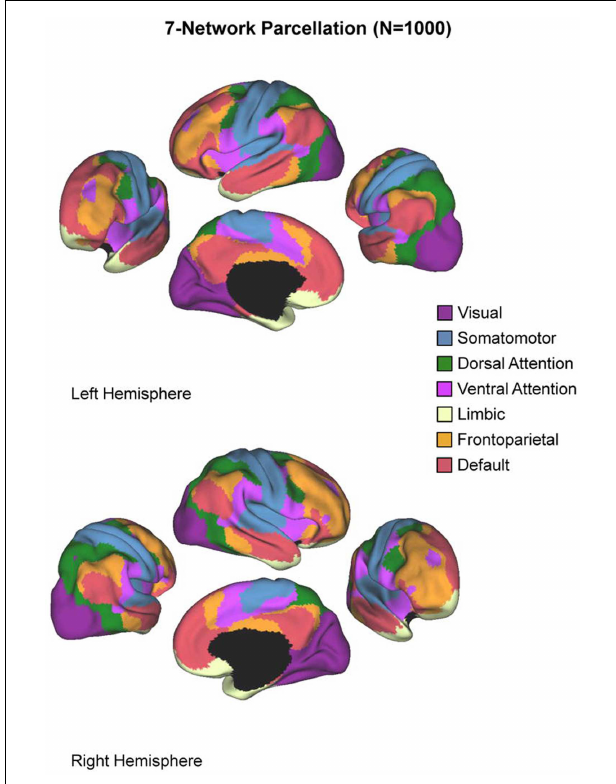
FIGURE 1 |The seven-network parcelation . Figure reproduced from Castellanos and Proal (3) .